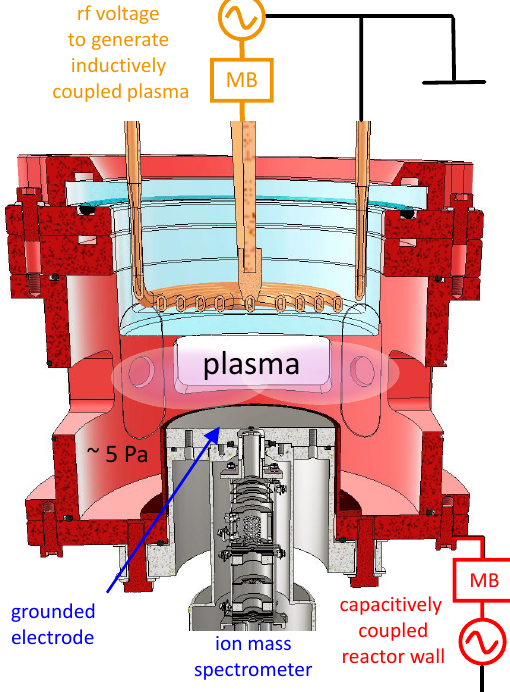
Figure 2. Sketch of the chamber with inverted electrode geometry and with an additional planar coil (orange) in quartz dome (blue) to maintain inductive power coupling. The red color represents the parts driven by the rf voltage, grounded parts are sketched in grey. The parts are electrically isolated by a 1mm PTFE spacer. Some windows, screws, other small parts, and the grounded shielding cage are not